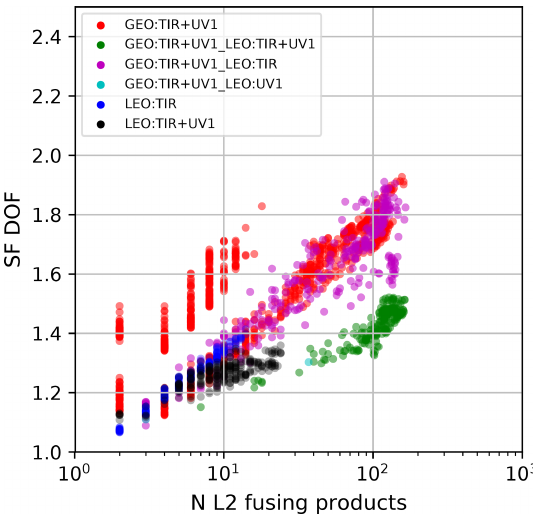
Figure 6. Scatter plot of SF DOF as a function of the number of L2 measurements fused in each coincidence grid cell; different colours represent different FUS